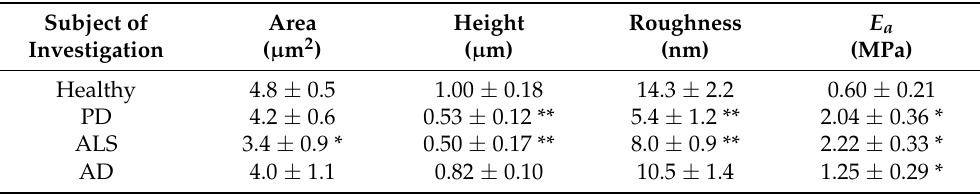
Table 1. Morphometric (H, A and R rms ) and nanomechanical ( E a ) parameters of platelets from patients with NDD and healthy individuals determined from the AFM images and force–indentation curves, mean values and SD.